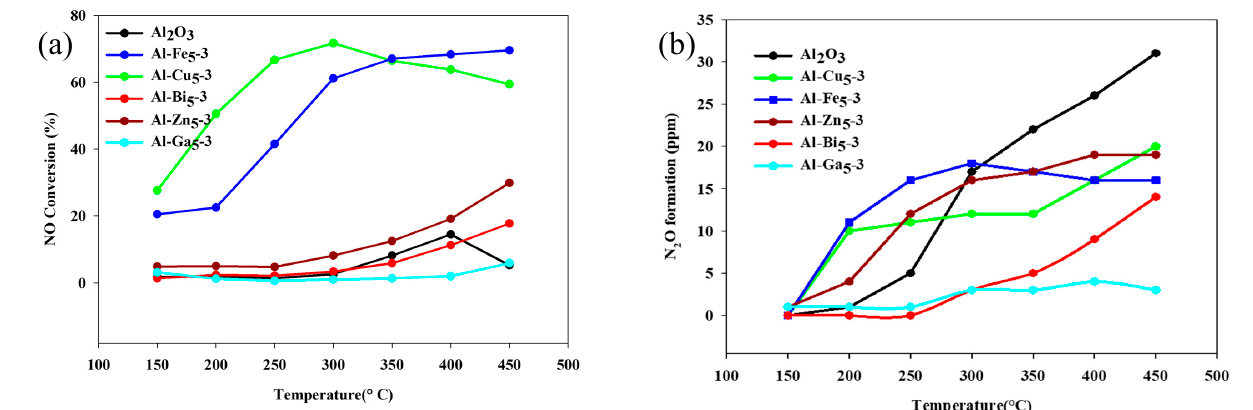
Figure 6. NO conversion ( a ) and the by-product N 2 O formation ( b ) over pristine Al 2 O 3 -3 and different metal oxide incorporated samples (Al-Me 5 -3).